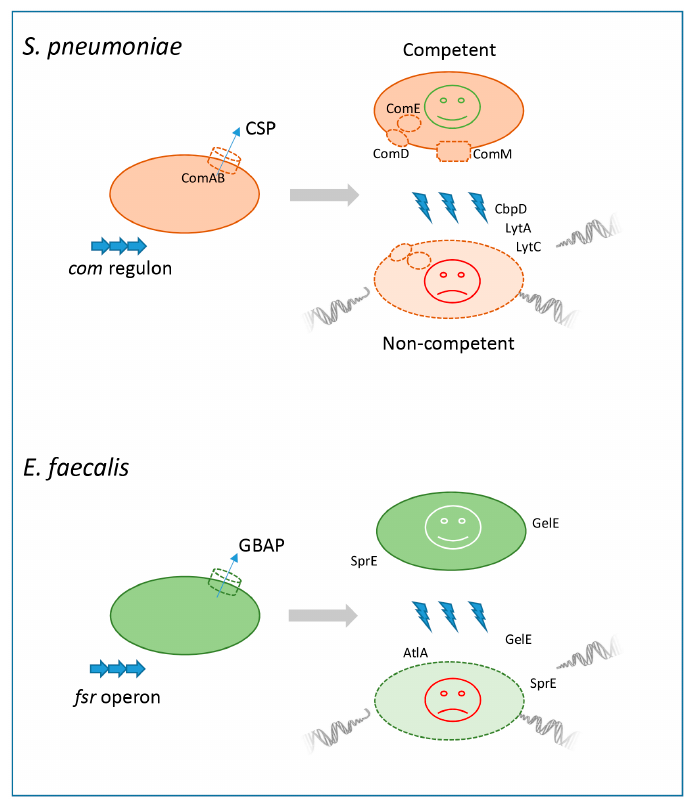
Figure 1. Fratricide in Streptococcus pneumoniae and enterococcal “siblicide”.